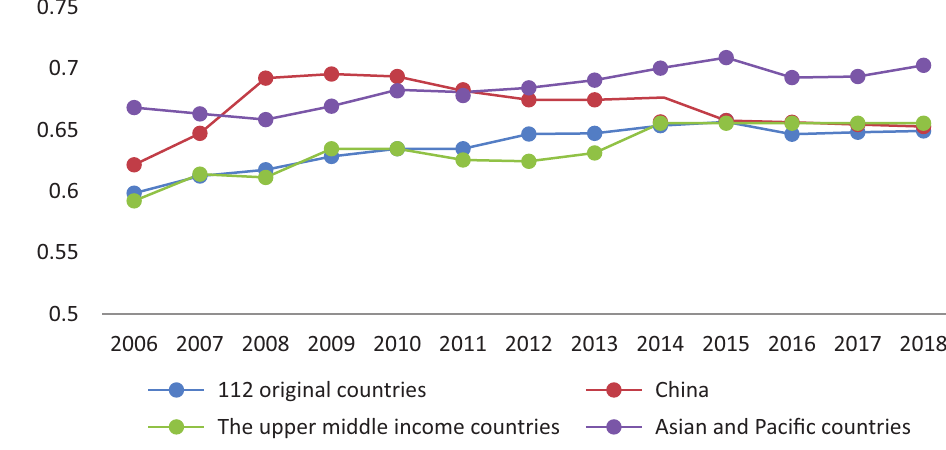
Figure 2. Time series comparison of economic participation and opportunities. Source: WEF (2006, 2008–2018). all score, with rapid growth of 0.023 (2.4%) from 2006 countries during the same period was 0.008 (0.9%). From